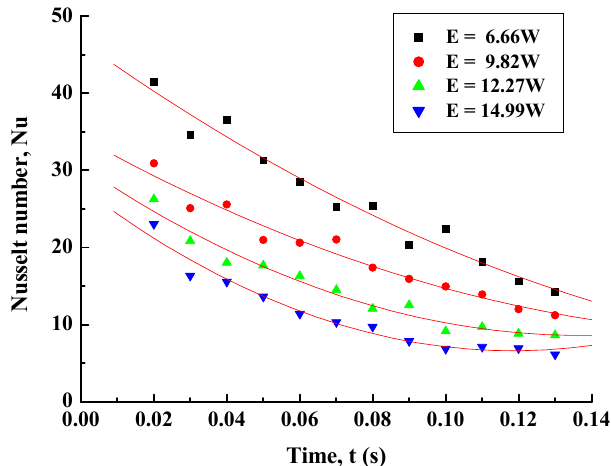
Figure 8. Variation in local Nusselt numbers for different heating energies with nickel sheet ( δ = 0.0100 mm).